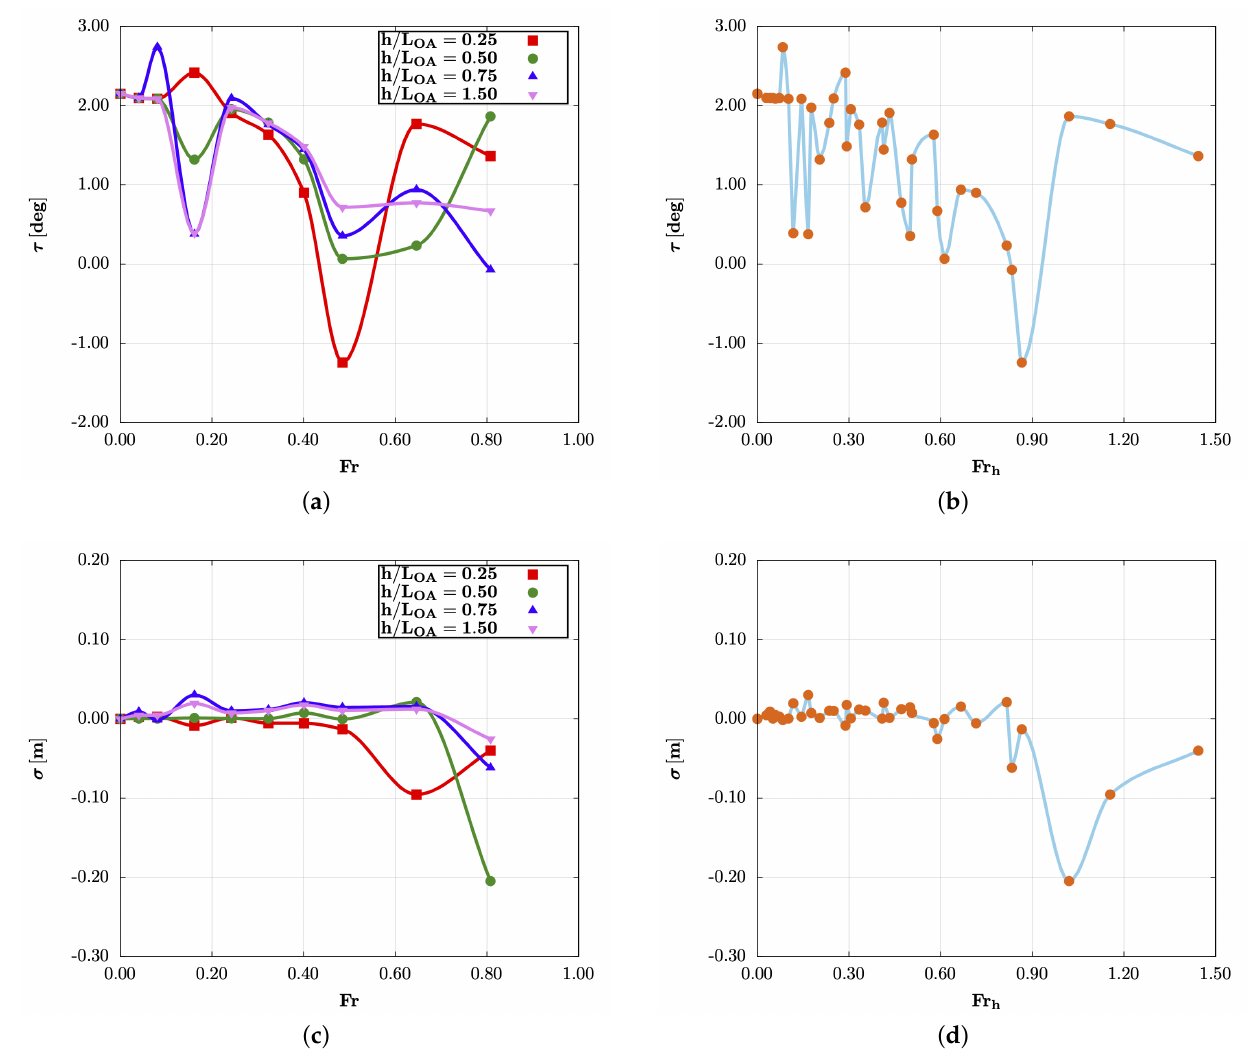
Figure 9. The effect of advance speed and depth on the dynamic motion of the catamaran; ( a ) trim angle versus Fr , ( b ) trim angle versus Fr h , ( c ) sinkage versus Fr , ( d ) sinkage versus Fr h